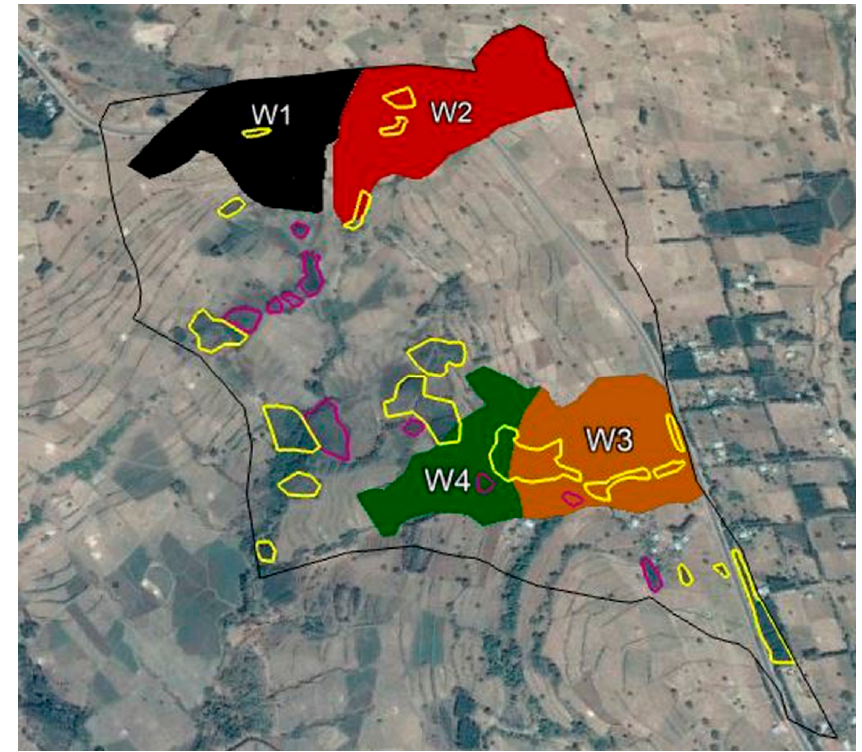
Figure 2. Eucalyptus tree expansion in the Debre Mawi Watershed (Google earth). Black is the boundary of the main watershed; purple indicates the eucalyptus area in 2010, and yellow indicates additional eucalyptus by 2018. W1, W2, W3, and W4 are the nested watersheds in the main watershed W5.